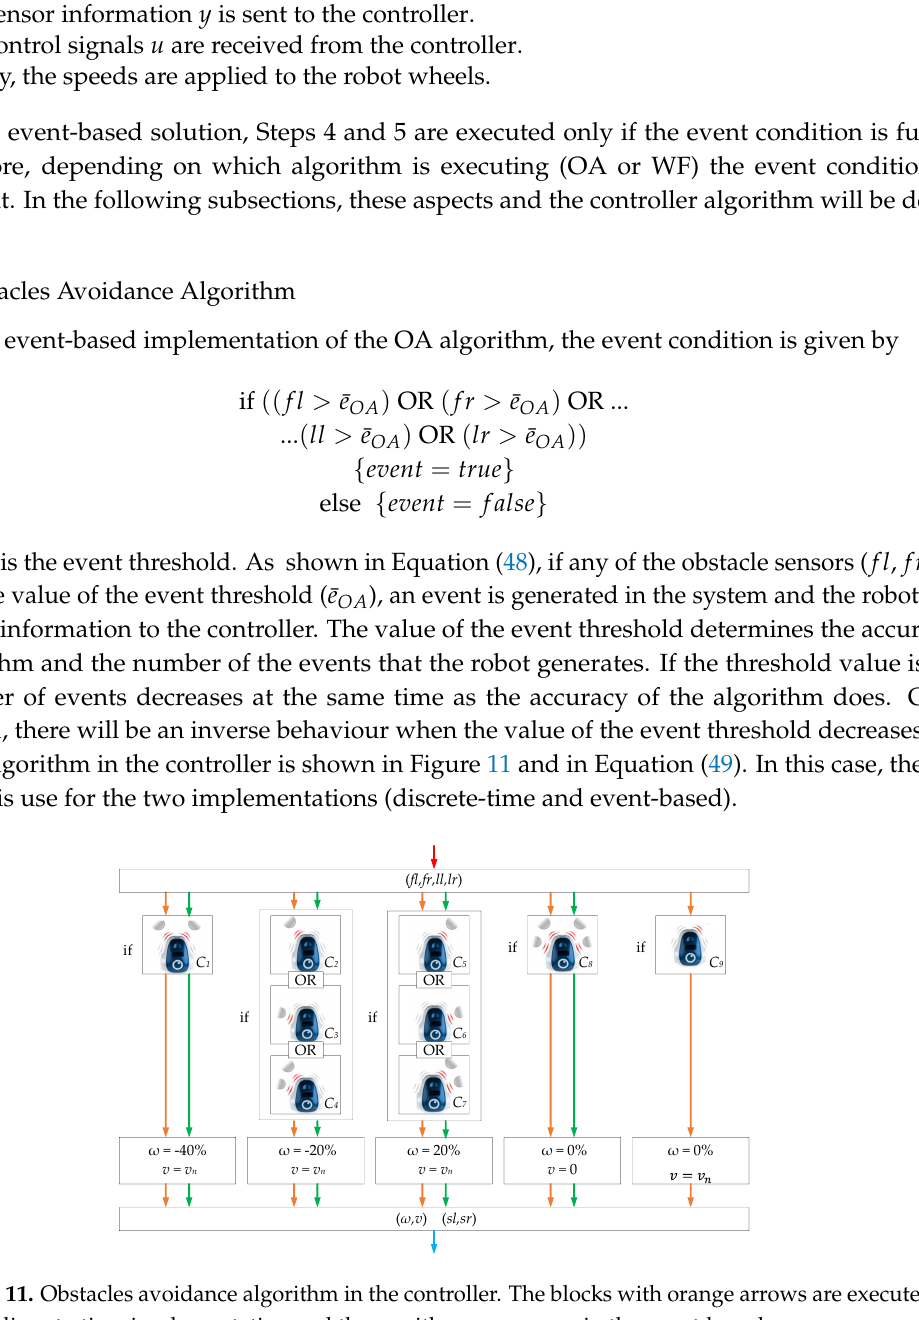
Figure 11. Obstacles avoidance algorithm in the controller. The blocks with orange arrows are executed in the discrete-time implementation and those with green arrows in the event-based